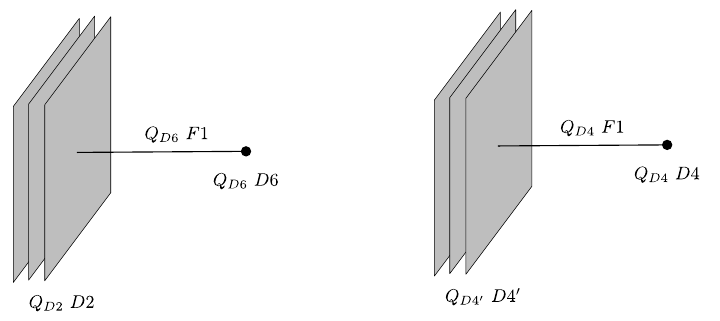
Figure 7 . Wilson loop in the Q D 6 ( Q D 4 ) antisymmetric representation of U( Q D 2 ) (U( Q D 4 0